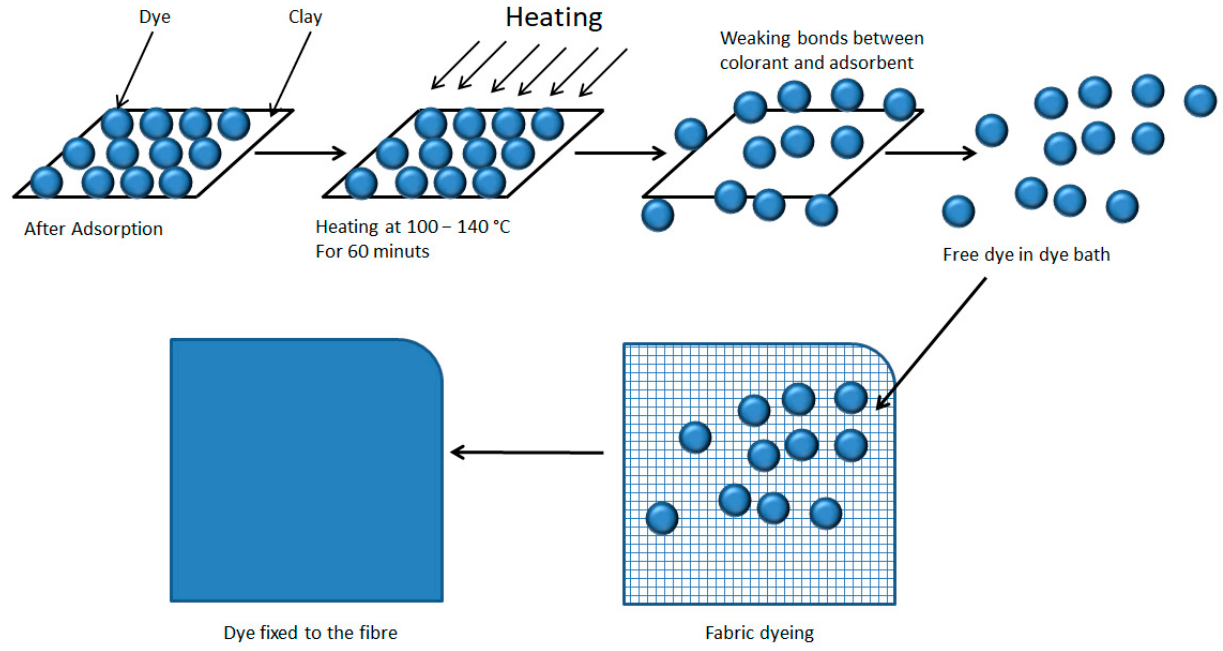
Figure 11. Dye desorption and dyeing of the textile fibre. The clay-dye hybrid is then used as a dyeing material for dyeing by exhaustion, using a bath ratio of 1/40. For the dyeing of a 100% cotton (CO) openwork fabric with a grammage of 135 g · m − 2 , 25 yarns · cm − 1 , 22 weft · cm − 1 of plane weave openwork fabric, the direct dye hybrid HDB199 is used, 40% s.p.f. of clay + dye, 20 g · L − 1 of sodium sulphate and three drops of a wetting agent are added to the dyeing bath to submit it to the dyeing process for 60 min at 100 ◦ C, obtaining the dyed fabric referenced as TDB199. For the dyeing of a 100% polyester fabric (PES) 200 g · m − 2 , 13 yarns · cm − 1 , 52 weft · cm − 1 of plain weave was introduced in a bath containing 40% s.p.f. of clay + HDR1 dye, for 60 min at 140 ◦ C in a closed machine with 1 g · L − 1 ammonium sulphate, 0.5 g · L − 1 Dekol SN dispersant after previously adjusting the pH to 4.5–5 with acetic acid, thus obtaining the sample with reference TDR1. The last dyeing was on a fabric of 100% acrylic composition (PAN) a weft knitted fabric with eight rows per centimetre and nine columns per centimetre forming an English knitted weave in whose bath 40% s.p.f. of clay + HBY2 dye, acetic acid 2% s.p.f., 20 g · L − 1 of sodium sulphate was added and processed for 40 min at 100 ◦ C, thus obtaining the dyed fabric referenced as TBY2. The dyeing of the polyester fabric was carried out in a closed machine due to the temperatures above 100 ◦ C that must be used. The apparatus used was the Testherm type 9S from the manufacturer Talcatex S.A, San Sebastian de los Reyes (Spain). Conversely, the dyeing of acrylic and cotton fibre was carried out in the open machine referenced as Open Bath dye Master from the manufacturer Paramount S.A, Geneva (Switzerland). All the fabrics were washed after dyeing to eliminate any remaining dye that was not fixed to the